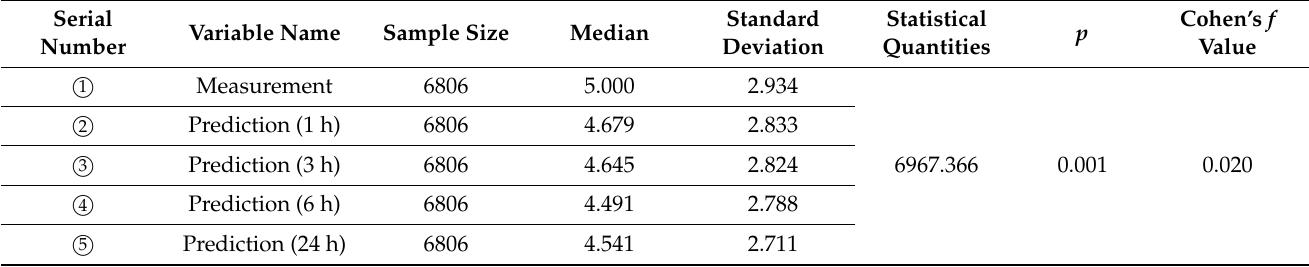
Table 3. The Friedman test results using LSTM.